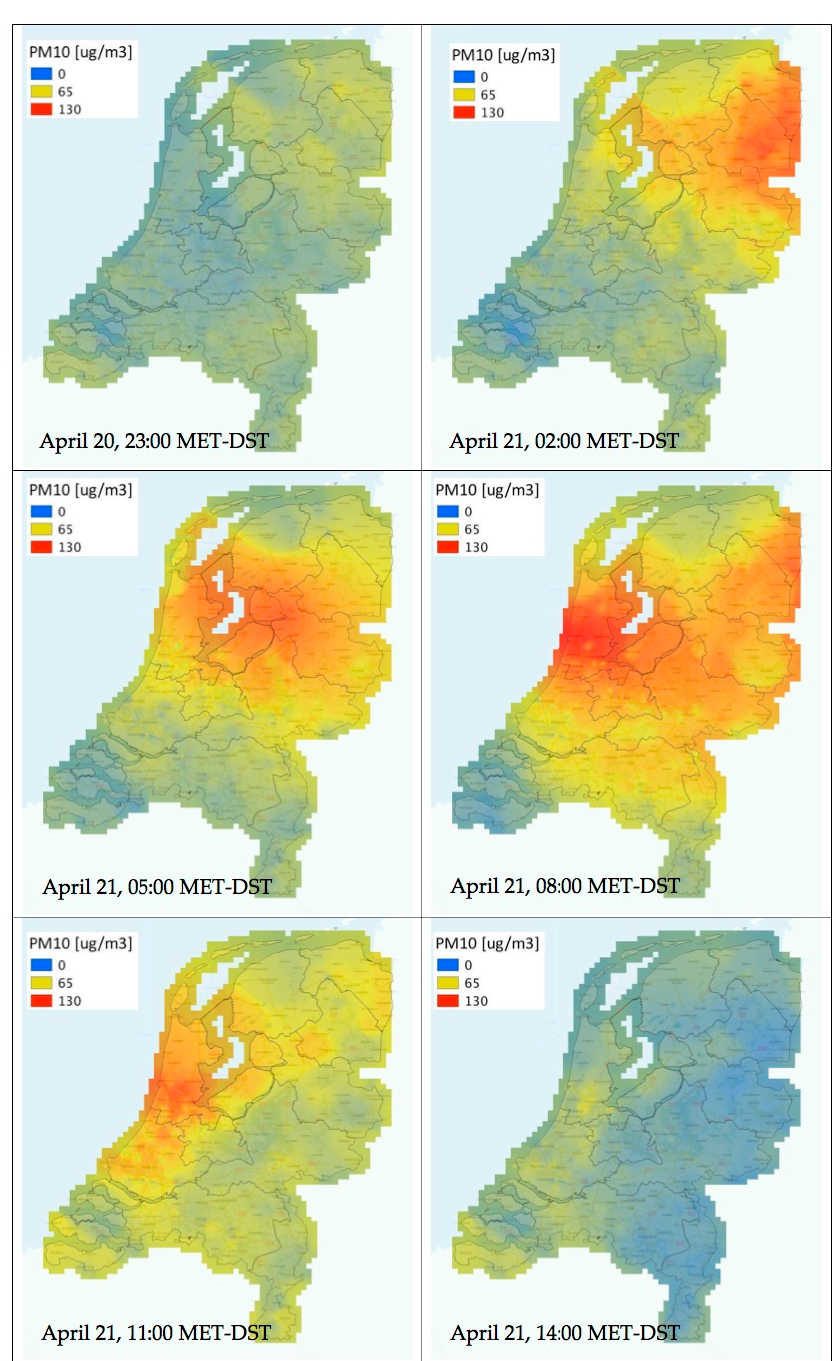
Figure 7. Maps of the dust cloud moving over the Netherlands during Easter 2019, using information from 45 official measuring stations and some 350 dust sensors. The dust in the plumes consisted mainly of PM 2.5 . Blue colors indicate 0 µ/m 3 , red indicates 130 µg/m 3 . From top-left to right-bottom, the maps are for 20 April, 23:00 until 21 April, 14:00, in steps of 3 hours.